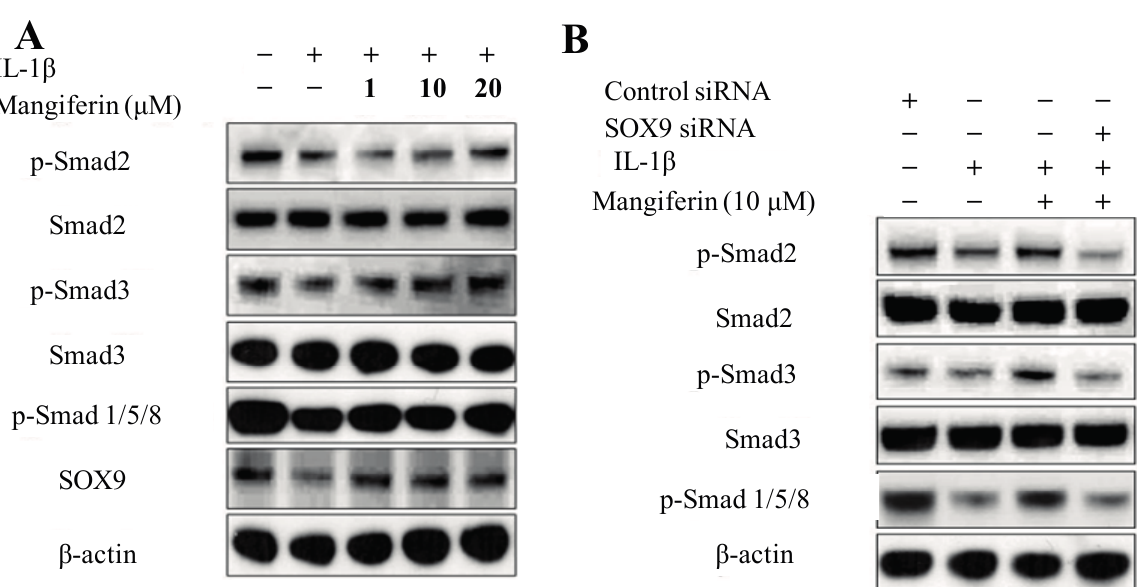
Figure 5. Effects of mangiferin on the phosphorylation of the Smad and SOX9 signaling pathways in IL-1 β -stimulated mesenchymal stem cells (MSCs). ( A ) Mangiferin upregulates the phosphorylation of Smad 2, Smad 3, Smad 1/5/8, and the SOX9 signaling pathways. MSCs were prestimulated with IL-1 β (5 ng/mL) for 1 h and then treated with the indicated dose of mangiferin for 72 h. Whole cell lysates were subjected to Western blotting with the indicated antibodies; ( B , C ) SOX9 deficiency inhibits the phosphorylation of Smad 2, Smad 3, Smad 1/5/8, aggrecan, and Col2 α 1. β -actin served as an internal control. MSCs were transfected with control siRNA or SOX9 siRNA and then treated with or without mangiferin for 72 h. Whole cell lysates were subjected to Western blotting with the indicated